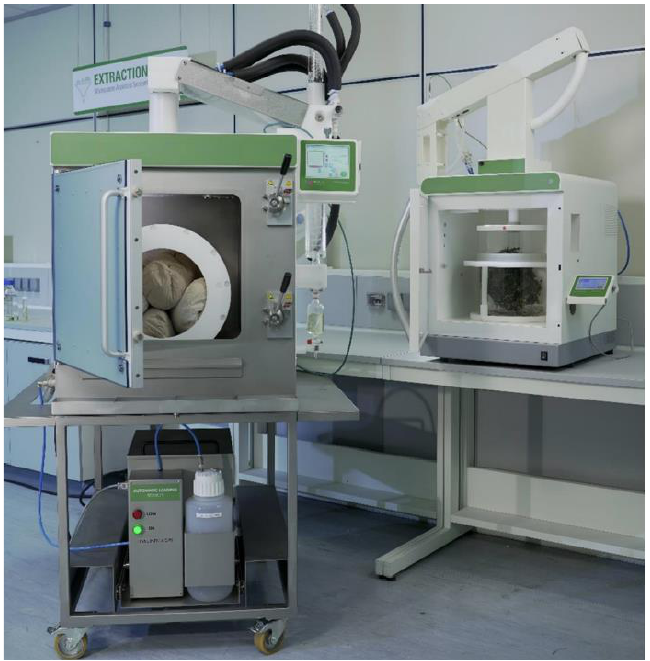
Figure 6. Ethos XL and Ethos X (Milestone Srl), DSTF — University of Turin.